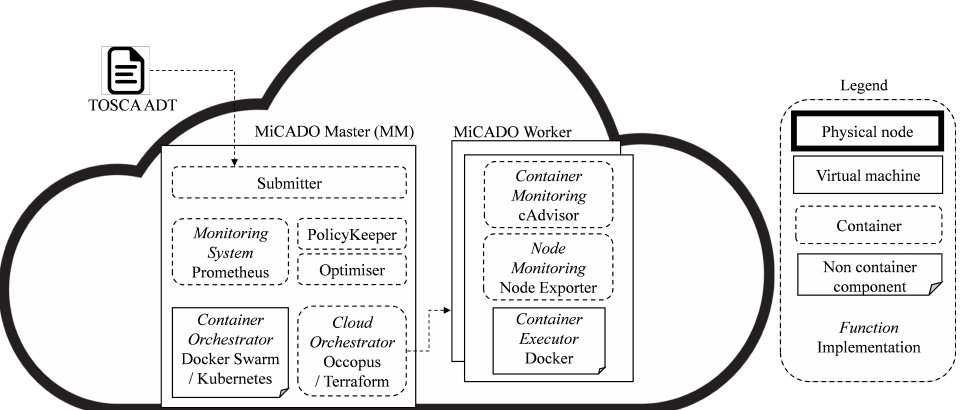
Figure 3. High-level architecture of the MiCADO orchestration